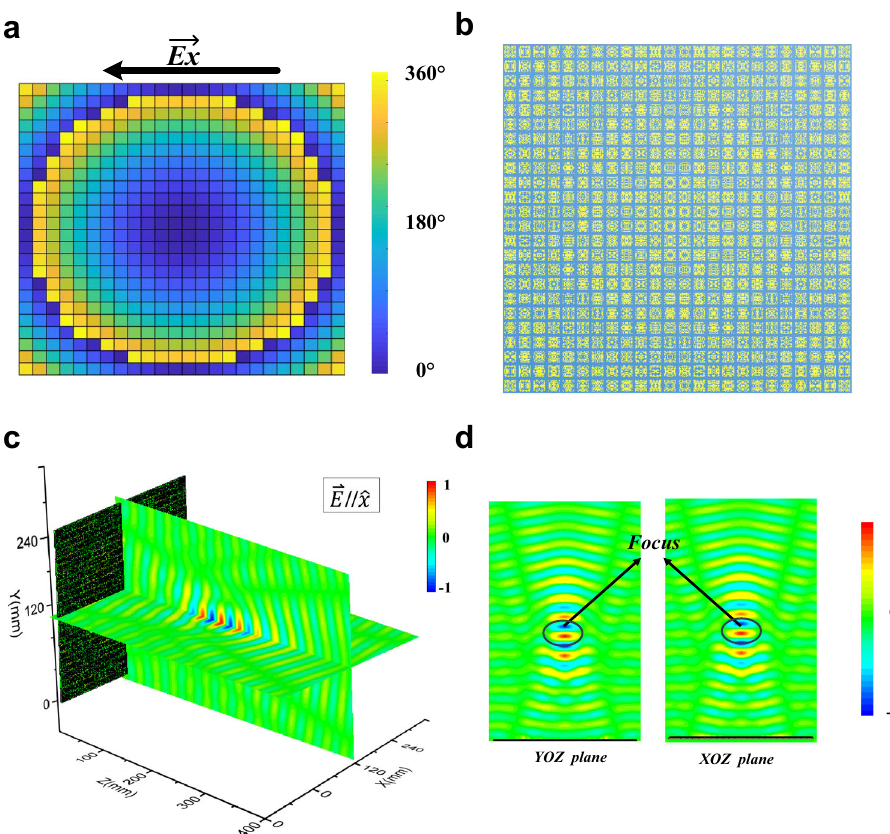
Fig. 4 Focusing metasurface design using the trained transfer learning model. a 2D phase distributions on the focusing metasurface. b Pattern of the focusing metasurface generated monolithically by the trained transfer learning model, which consists of 24 × 24 meta-atoms predicted according to the phase pro fi le. c 3D snapshot of re fl ected electric fi elds above the metasurface. d The distributions of Ex on YOZ plane and Ey on XOZ